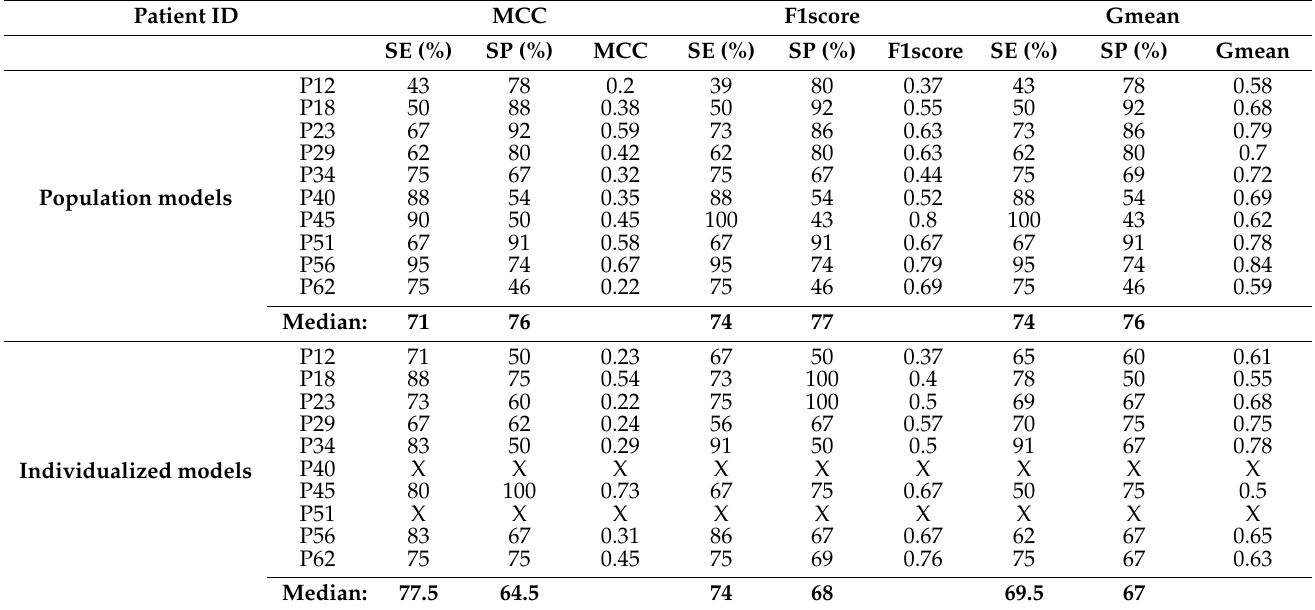
Table 2. Median sensitivity (SE) and specificity (SP) of the model using support vector machines (SVM), including physical activity measures. Three different performance metrics were evaluated: MCC, F1score and Gmean. Results are presented in percentage. Non-evaluated results are marked as X.